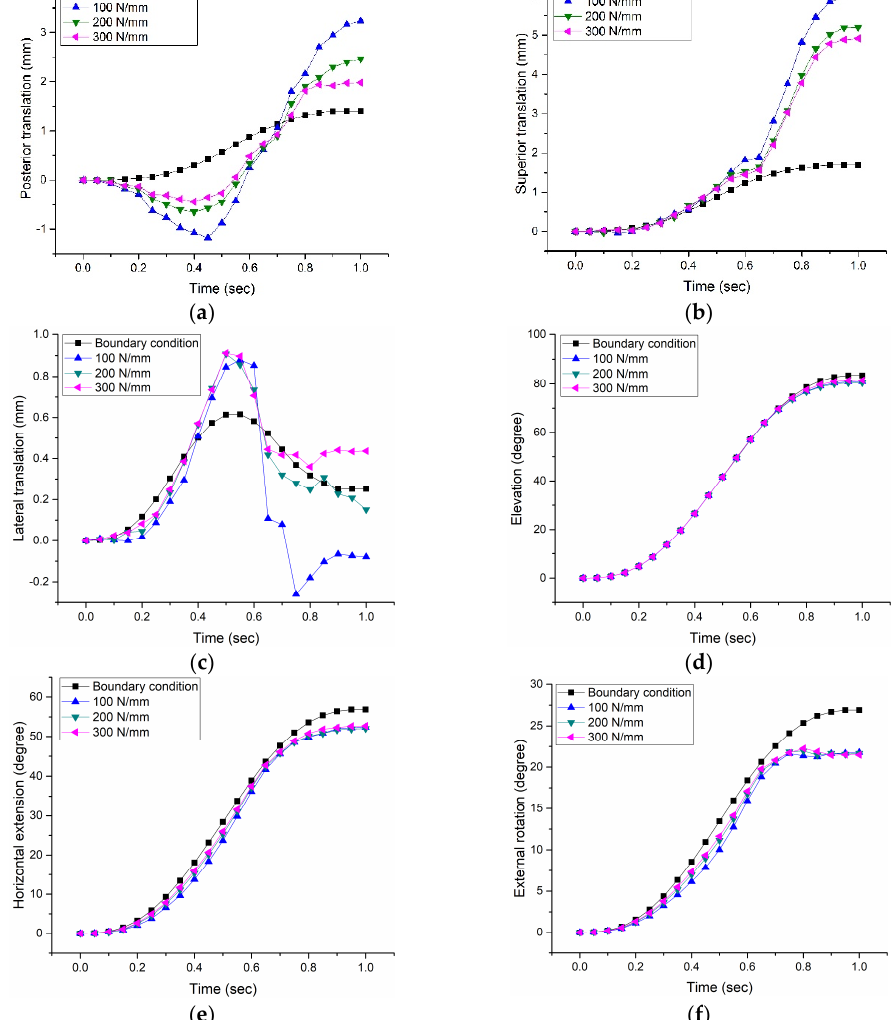
Figure 7. The motion comparison of guidance and follower by the proposed method: (a) Posterior translation; (b) Superior translation; (c) Lateral translation; (d) Elevation; (e) Horizontal extension; (f) External rotation.